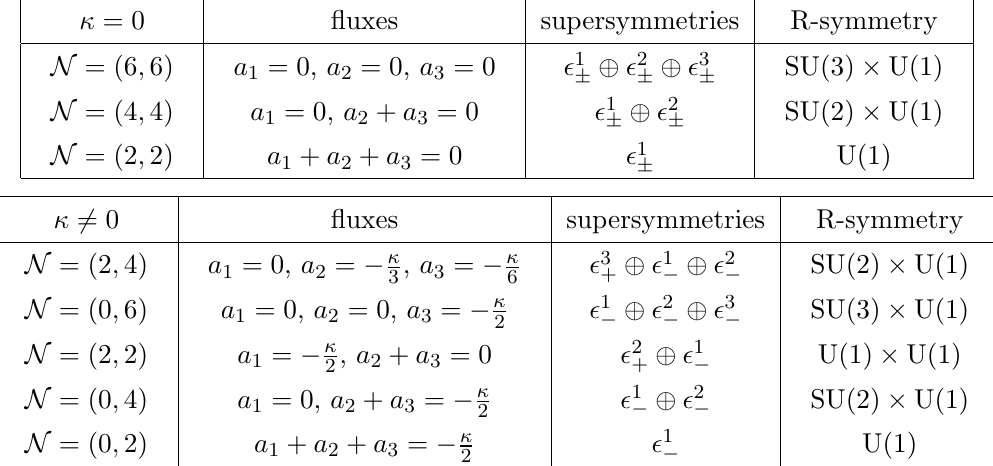
Table 8 . Classi(cid:12)cation of topologically twisted 4d N = 3 SCFTs on constant curvature Riemann surfaces in terms of the surviving amount of supersymmetry in 2d. In the last column we